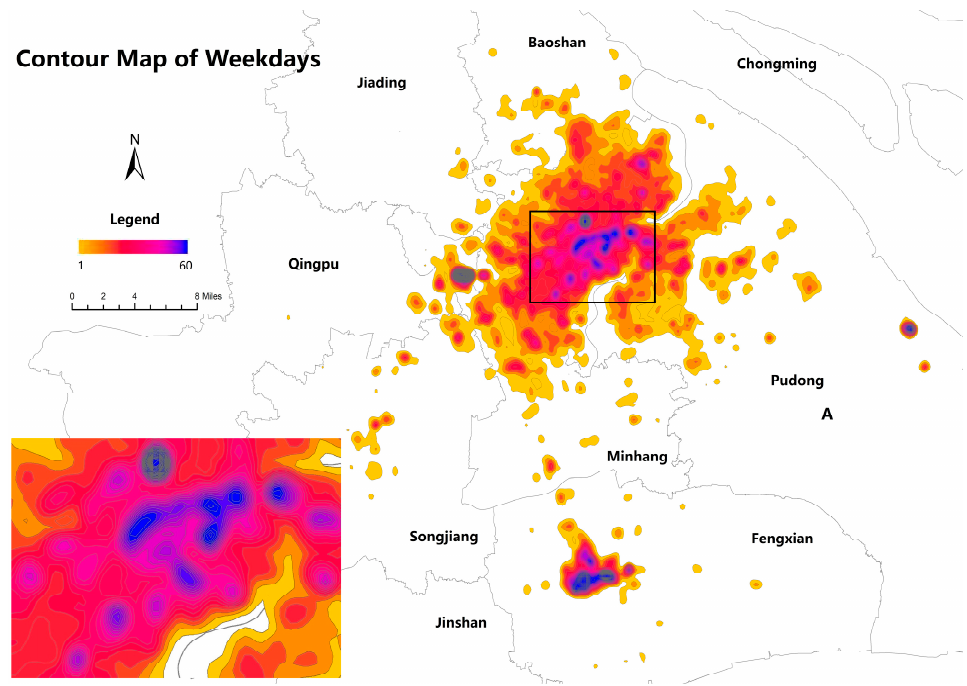
Figure 6. Weekday contour map.